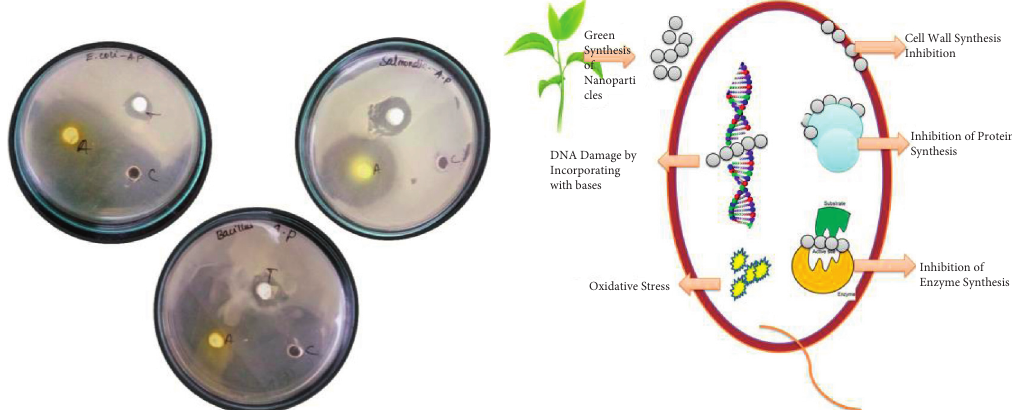
Figure 8: Antibacterial activity of TiO 2 NPs by A. paniculata and its mechanism of action.